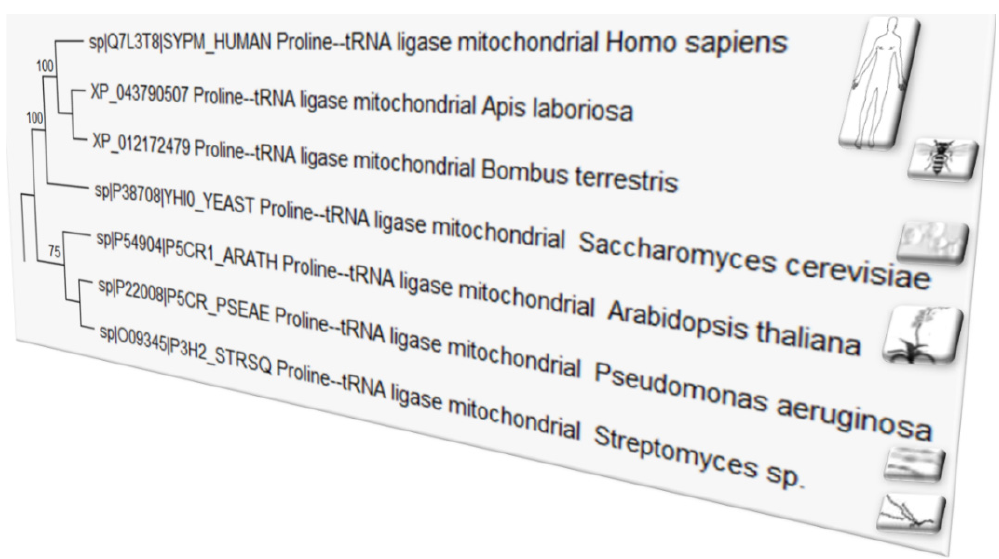
Figure 1. Phylogenetic tree based on maximum parsimony of the Proline-tRNA ligase, a mitochon- drial enzyme that participates in proline metabolism, predicting the evolutionary history of taxa.